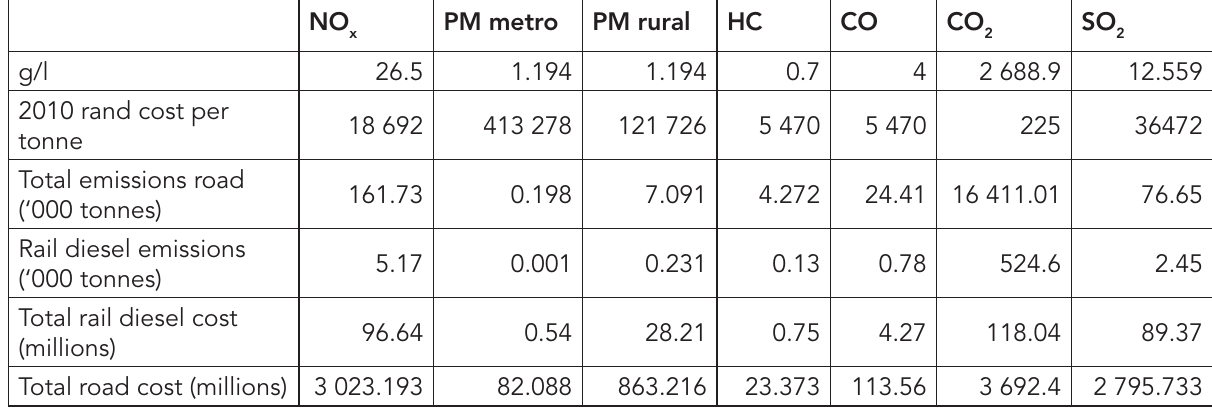
Table 2: Emissions per litre of diesel and PPP-adjusted GDP/capita transferred abatement cost of emissions per